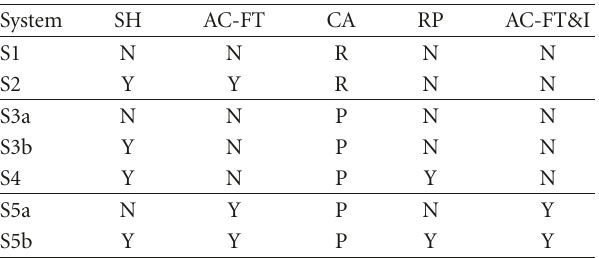
Table 1: Features of the systems studied.